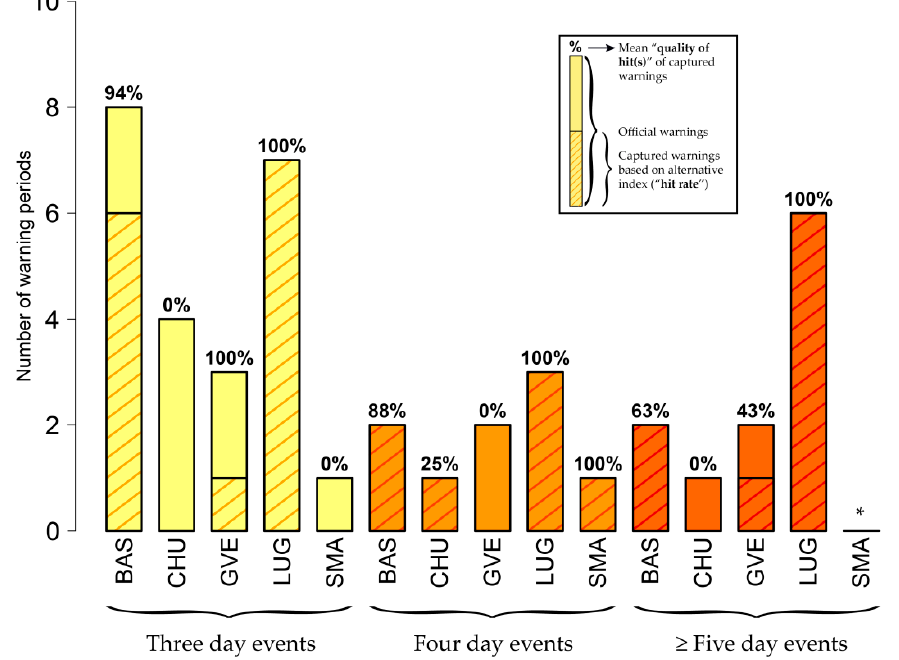
Figure 12. Matches of overlapping warning periods based on wbt (Swiss-wide threshold) compared to hi. The warning periods result from the use of Swiss-wide thresholds (i.e., the number of warning days is different for the hi and the alternative index, see Section 3.2.2). Compared to the number of warning days calculated with the site-specific threshold (WD site ), the number of warning days changes individually for each station when using a Swiss-wide threshold (WD CH ): BAS (WD site #119 vs. WD CH #154), CHU (WD site #70 vs. WD CH #33), GVE (WD site #96 vs. WD CH #53), LUG (WD site #111 vs. WD CH #509) and SMA (WD site #31 vs. WD CH #38). The figure presents matches for three- (yellow), four- (orange) and five- (or more, dark orange) day official warning events. The shaded bars give the number of official warning periods for the respective duration. The dashed bars show the number of warning periods captured by wbt (indicating the “hit rate” when compared to the length of the entire bar). The percentage on each bar gives the mean “quality of hit(s)”. In Basel (BAS) and for the case of three-day warnings, for instance, six warning periods based on wbt show an overlap with (in total) eight official three-day warning events (“hit rate” of 75%). In the mean, these overlapping warnings show a 94% match (“quality of hits”). The asterisk applies to stations without any official warning periods in the respective category.